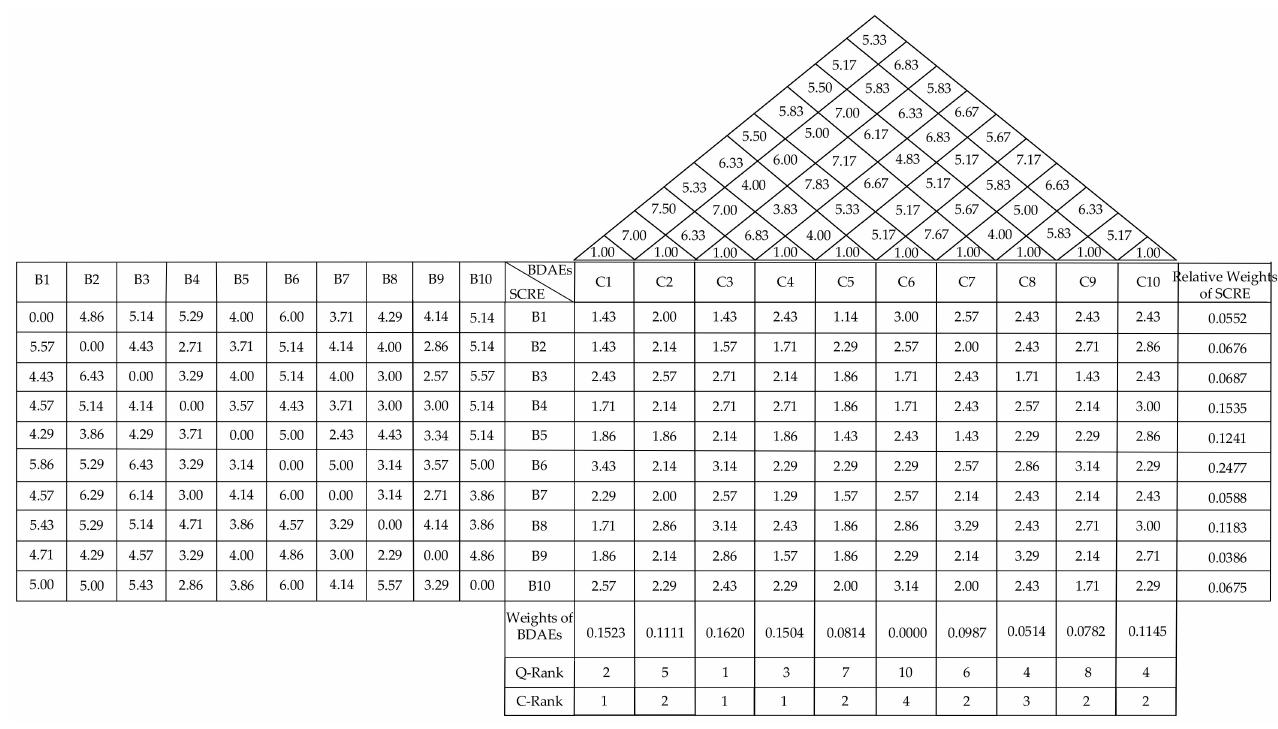
Figure 4. The second stage of